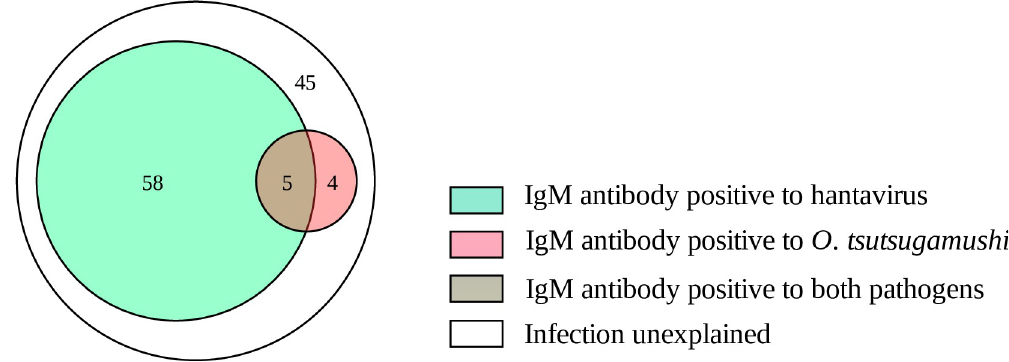
Fig 1. Venn diagram indicates the relationship among clinically suspected HFRS patients.